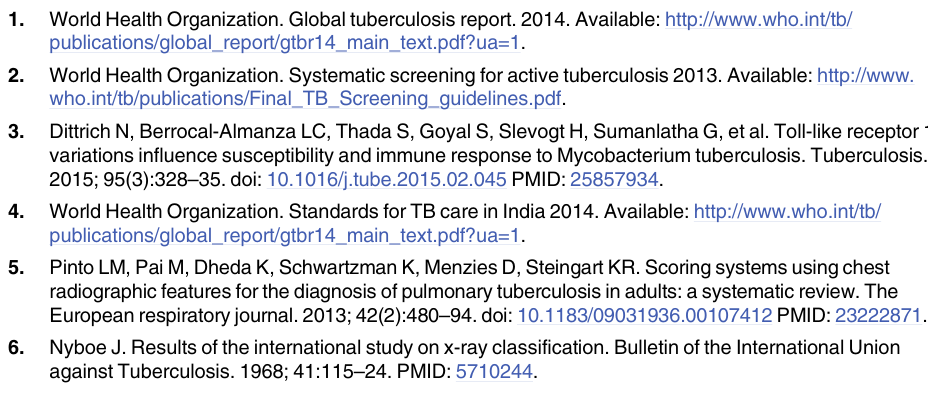
S1 Fig. Sketch showing the division of each lung into two parts by a horizontal line used to determine the area of lung affected. S2 Fig. Chest radiographs of four patients with newly diagnosed smear positive TB. In each radiograph a lesion is marked by an arrow. There was either agreement (a, b) or no agreement (c, d) among radiologists in interpreting these lesions as cavities. S3 Fig. There is no difference in weight gain between patients according to the area of lung affected. The BMI gain in (kg/m 2 ) after 6 months DOTS treatment was calculated by subtract- ing the BMI at 0 months to the BMI at 6 months and was compared between patients accord- ing to the area of lung affected. Data are represented as the median ± interquartile range (IQR) and statistical difference was assessed with Kruskal-Wallis test, n = 9 in 25%, n = 30 in 50%, n = 14 in 75% and n = 6 in 100%. S1 Table. Characteristics of study participants stratified by the presence of alveolar infil- trates and cavitation. S2 Table. Comparison of the presence of alveolar infiltrates and cavitation in cured and not cured